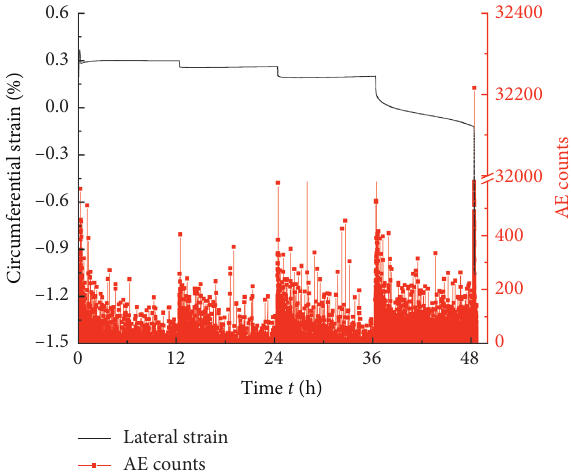
Figure 9: Lateral strain-time-AE count curve of constant deviatoric stress grade unloading confining